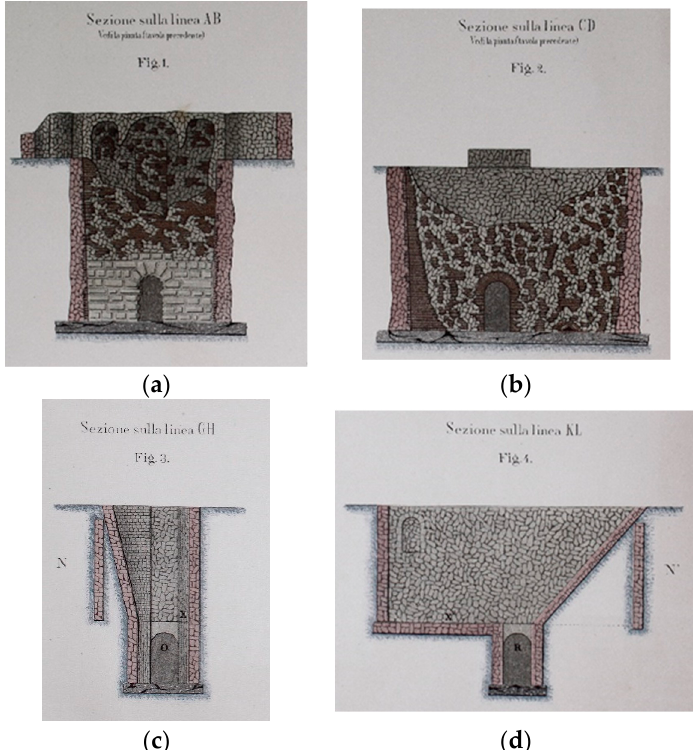
Figure 3. Sections of the Roman incile , by A. Brisse and L. De Rotrou [3]: ( a ) section AB of Figure 2; ( b ) section CD of Figure 2; ( c ) section GH of Figure 2; ( d ) section KL of Figure